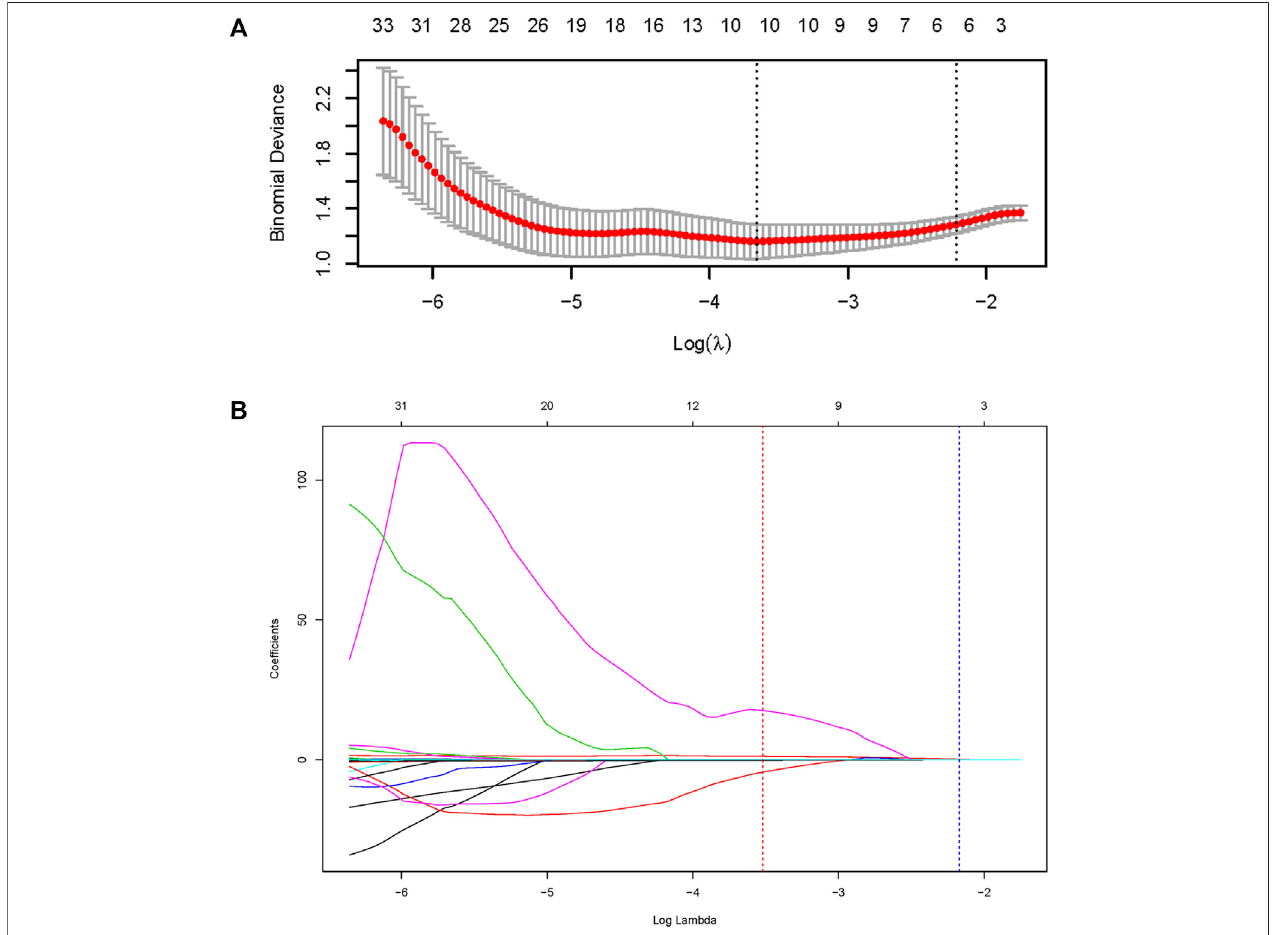
FIGURE 2 | Feature selection using the least absolute shrinkage and selection operator (LASSO) regression method. (A) The dotted vertical line was plotted at the value selected by the 10-fold cross-validation via minimum criteria (the value of lambda with the lowest partial likelihood deviance). (B) Selection of the tuning parameter (lambda) in the LASSO regression using 10-fold cross-validation via minimum criteria.